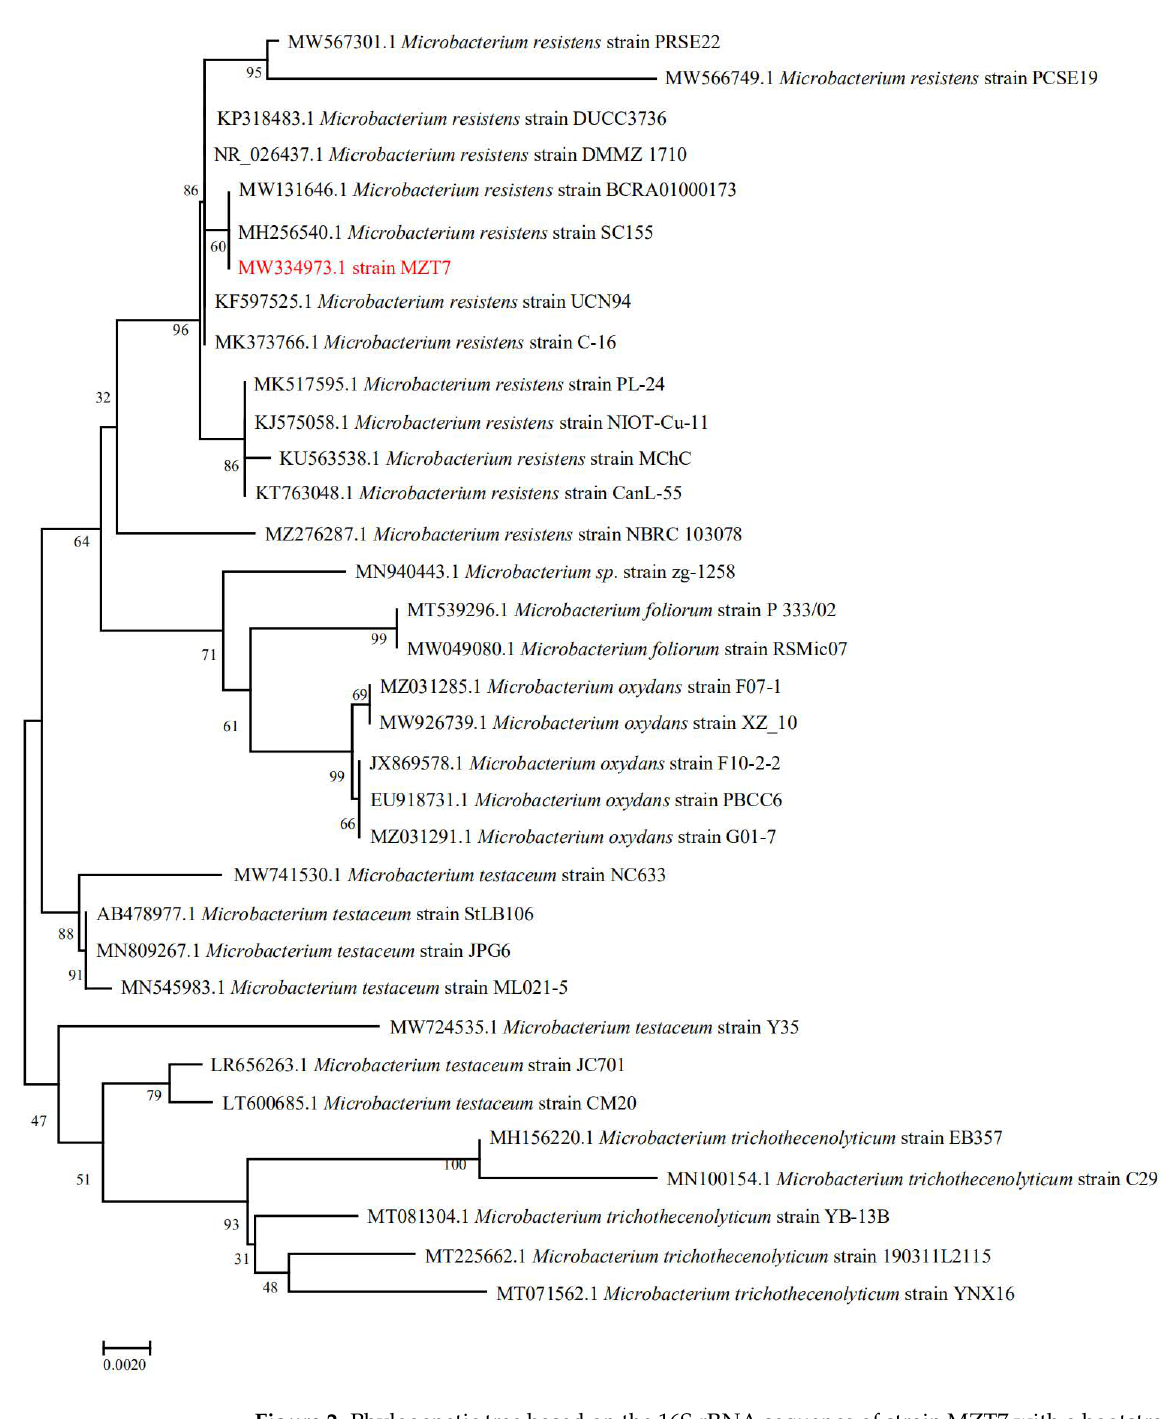
Figure 2. Phylogenetic tree based on the 16S rRNA sequence of strain MZT7 with a bootstrap value of 1000. The red label is the strain MZT7 isolated in this